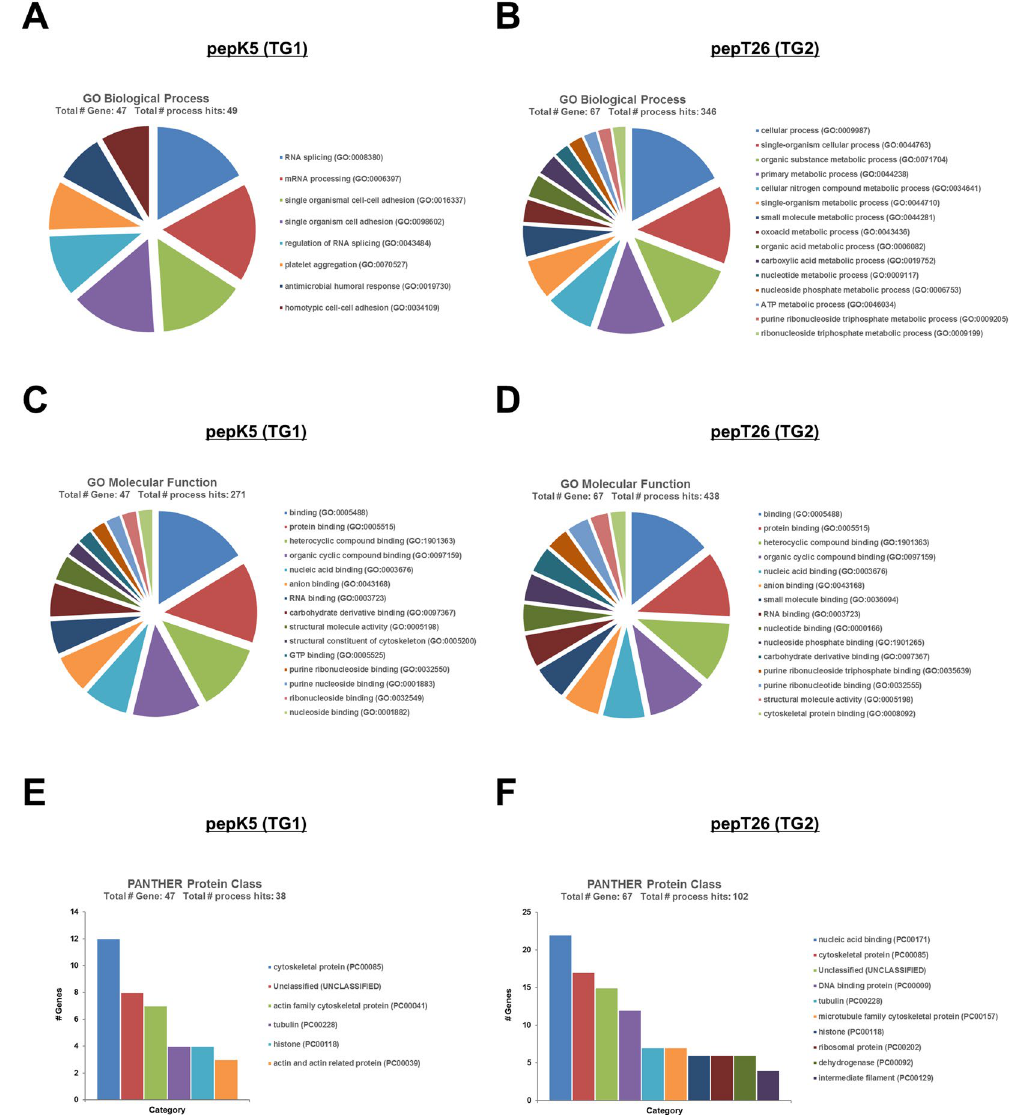
Figure 8. Gene ontology (GO) terms for possible substrates for TG1 and TG2 during renal fibrosis. GO analysis corresponding to biological process ( A ), molecular function ( B ) and PANTHER protein class ( C ) represented as pie and bar charts generated by PANTHER classification system